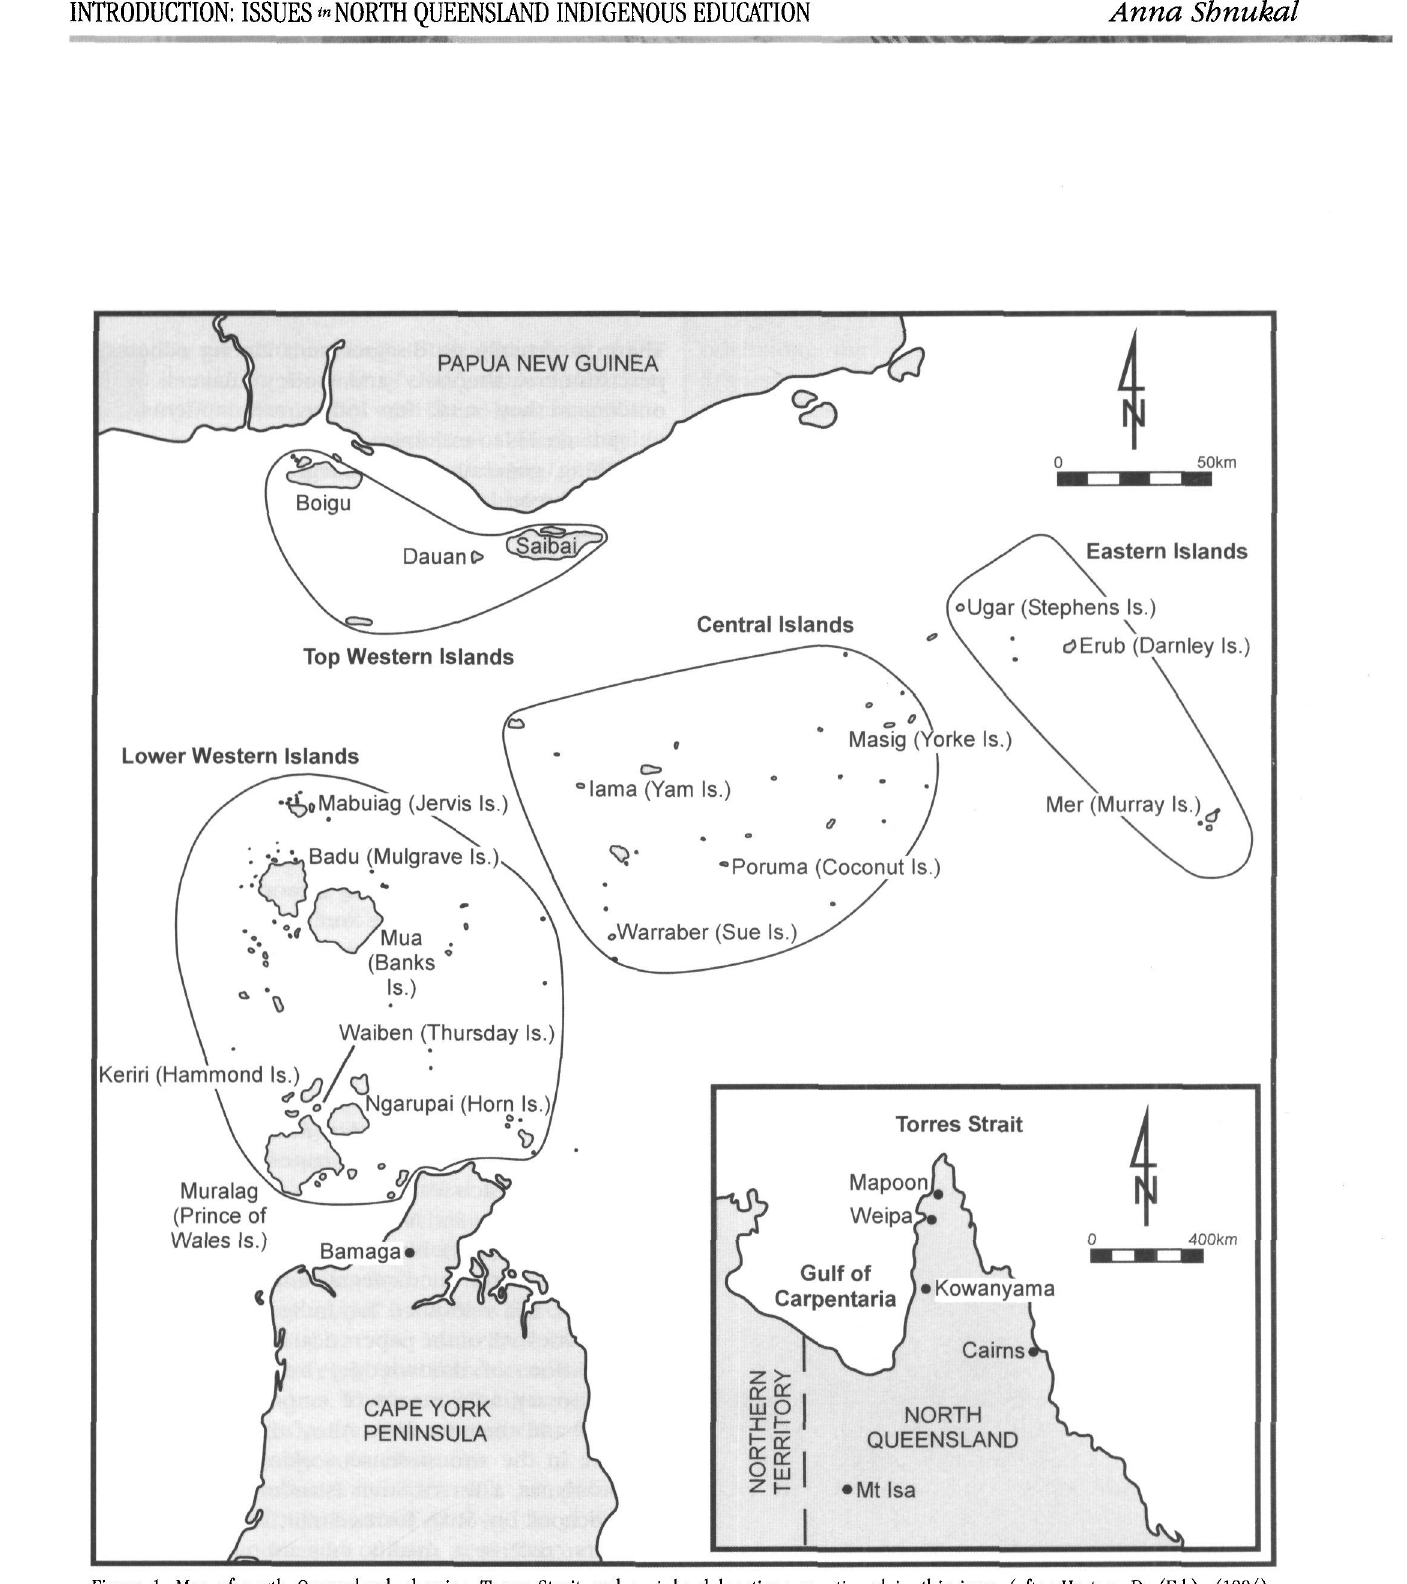
Figure 1. Map of north Queensland, showing Torres Strait and mainland locations mentioned in this issue (after Horton, D. (Ed.). (1994). The encyclopaedia of Aboriginal Australia, Vol. 2 (p.1091). Canberra: Australian Institute of Aboriginal and Torres Strait Islander